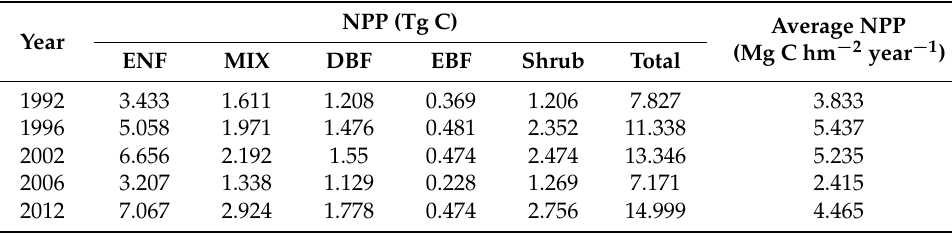
Table 5. NPP of Forest Ecosystem in Three Gorges Reservoir Area in 1992~2012.